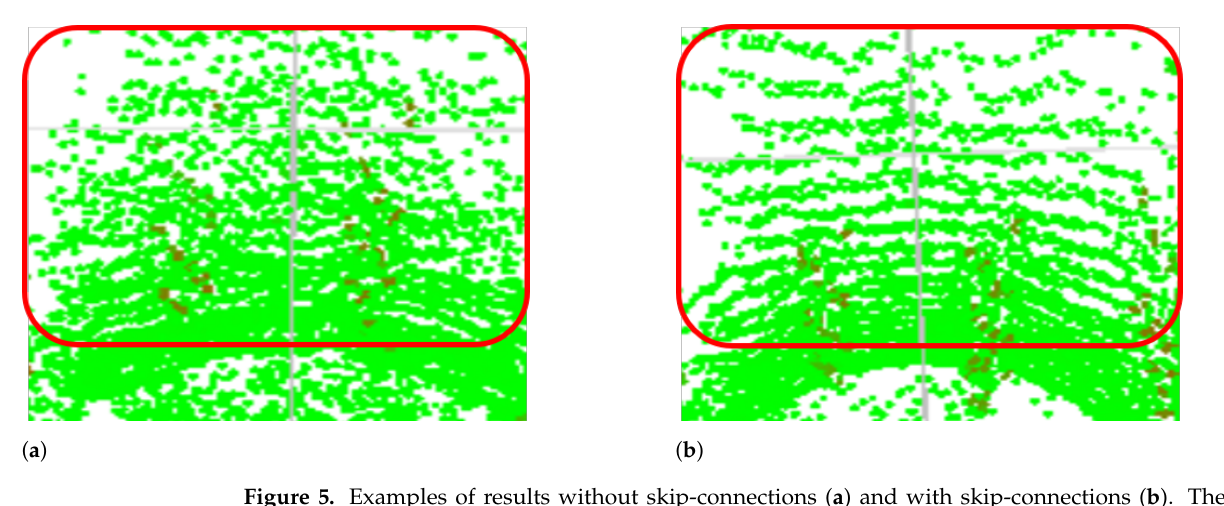
Figure 5. Examples of results without skip-connections ( a ) and with skip-connections ( b ). The results are the reconstructed 3D points seen from above. The green points indicate reconstructed 3D points. The red points indicate the comparatively high value of intensity. While the result without skip-connections did not generate LiDAR rings, that with skip-connections generated LiDAR rings clearly (see the red rectangles for comparison). The red rectangle on the right indicates the LiDAR rings, which are arrangements of LiDAR points that form